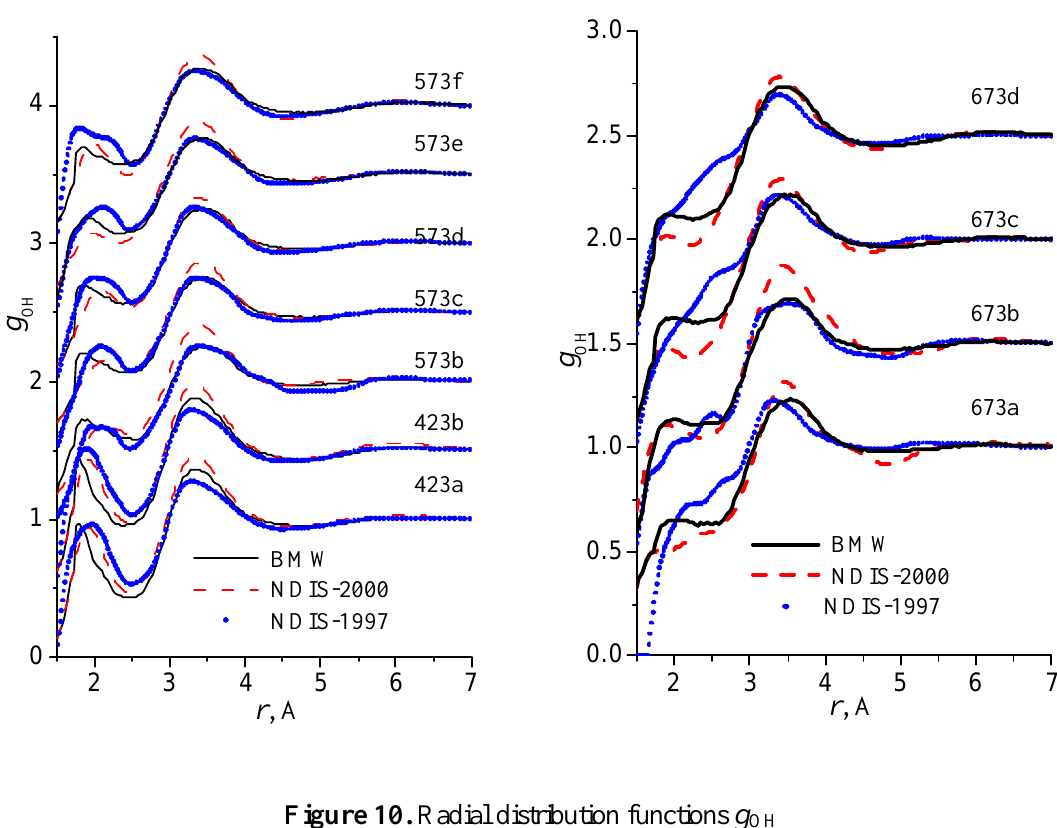
Figure 10. Radial distribution functions g